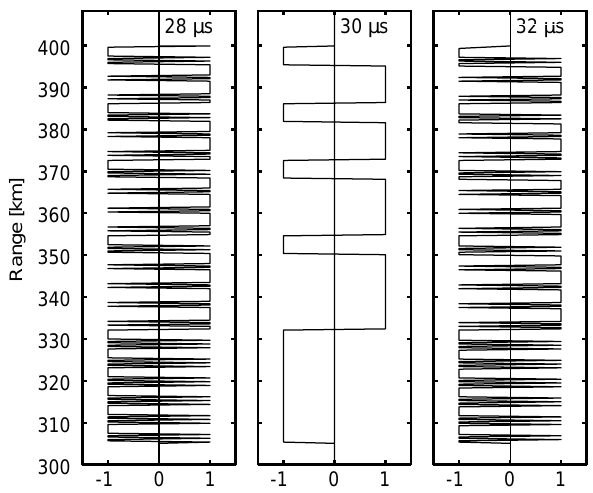
Fig. 5. Range ambiguity functions of the 28- µ s lag (left), 30- µ s lag (middle) and 32- µ s lag (right) for the modulation in Fig.